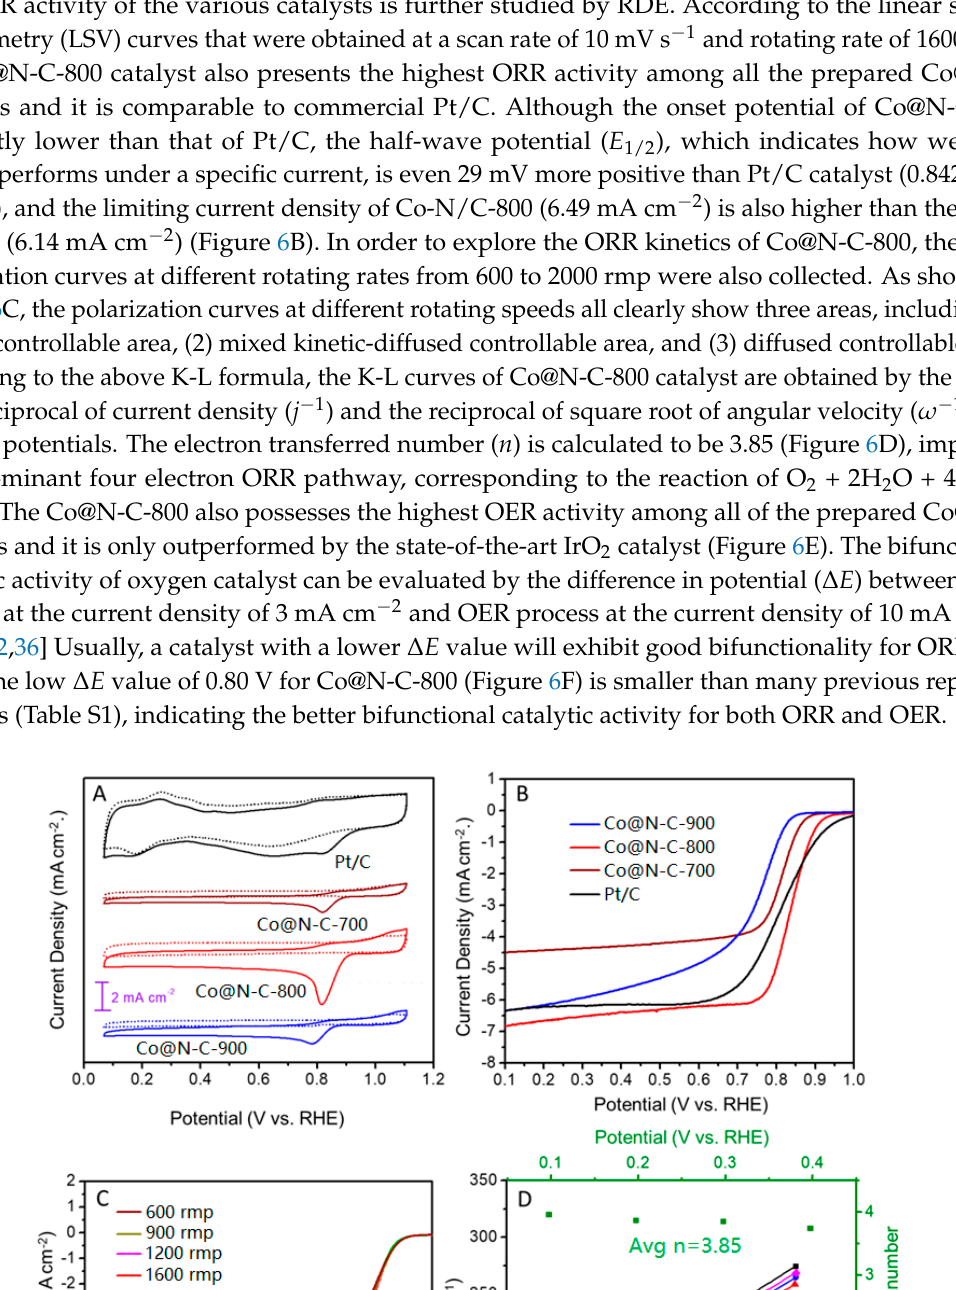
Figure 6. ORR and oxygen evolution reaction (OER) performances of Co@N ‐ C and Pt/C with the loading of 100 μ g cm − 2 using O 2 ‐ saturated 0.1 M KOH as electrolyte. ( A ) Static cyclic voltammogram (CV) curves of different catalysts (solid line: in O 2 ‐ saturated electrolyte; dotted line: in N 2 ‐ saturated electrolyte), ( B ) linear sweep voltammograms (LSV) plots of catalysts for ORR at 1600 rmp, ( C ) ORR polarization curves of Co@N ‐ C ‐ 800 at different rotating speeds (600 to 2000 rpm), ( D ) the K ‐ L plots of Co@N ‐ C ‐ 800 derived from rotating disk electrode (RDE) data and electron transfer number ( n ) per oxygen molecule (O 2 ) at potentials from 0.1 to 0.4 V, ( E ) LSV plots of catalysts for OER at 1600 rmp and ( F ) the bifunctional catalytic activities of Co@N ‐ C ‐ 800 within the ORR and OER potential window.